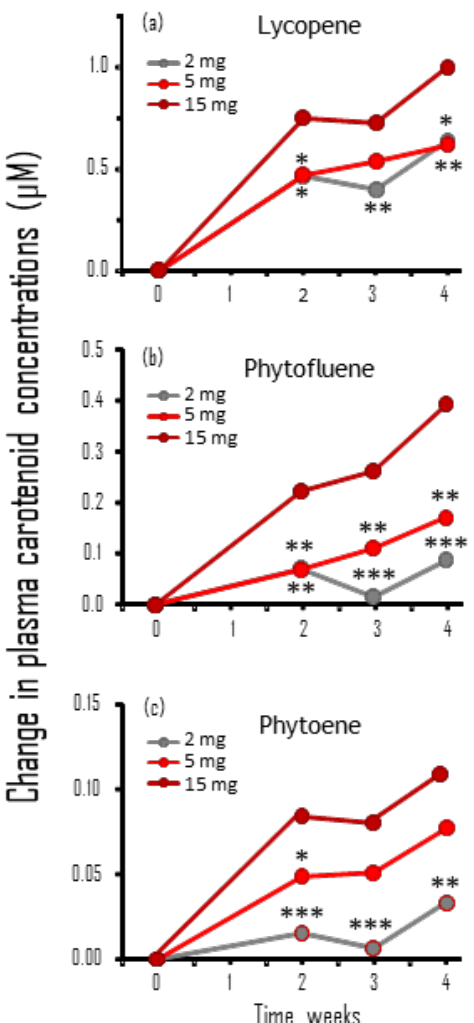
Figure 4. The increase in lycopene, phytofluene and phytoene concentrations after 2–4 weeks of treatment with TNC were significantly lower with TNC 5 mg and TNC 2 mg than with TNC 15 mg: ( a ) lycopene; ( b ) phytofluene; and ( c ) phytoene. Please note that the scale in the Y-axis is di ff erent for the three carotenoids. Results are the mean of individual changes in carotenoid concentrations of 25 subjects (TNC 2 mg and 15 mg) or 24 subjects (TNC 5 mg). SDs are not shown for graph simplicity. * p < 0.05; ** p < 0.01; *** p < 0.001 for the di ff erence at each time point between TNC 15 mg to TNC 2 mg or TNC 5